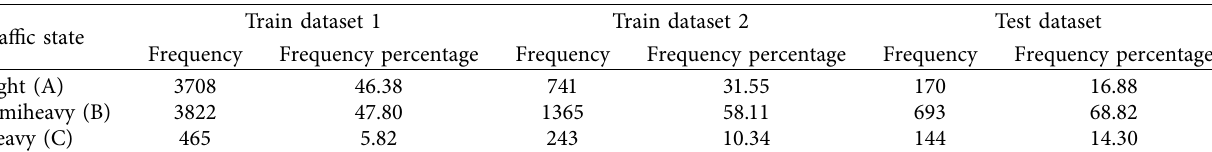
Table 3: Frequency of traffic states in